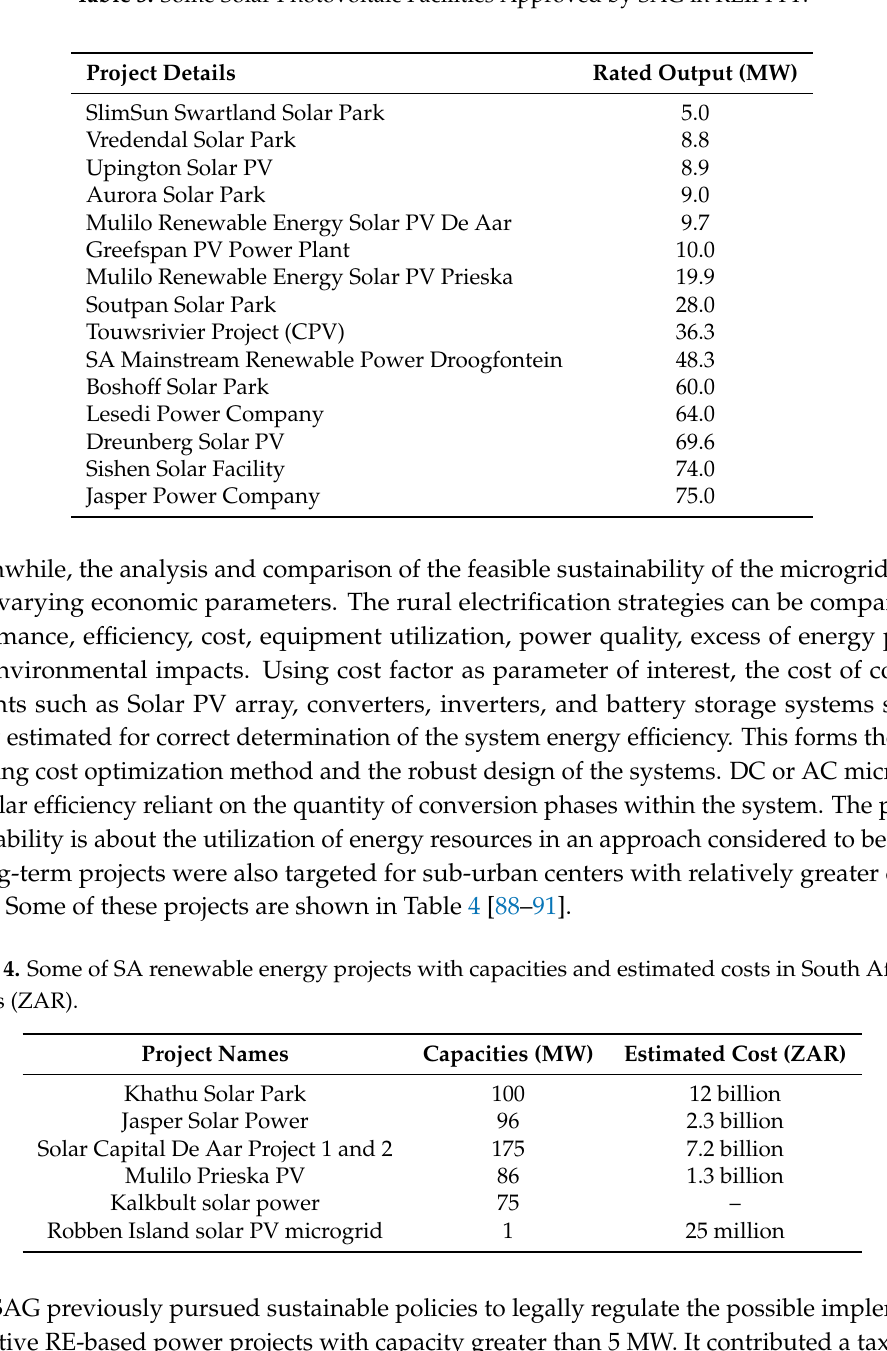
Table 3. Some Solar Photovoltaic Facilities Approved by SAG in REIPPPP.